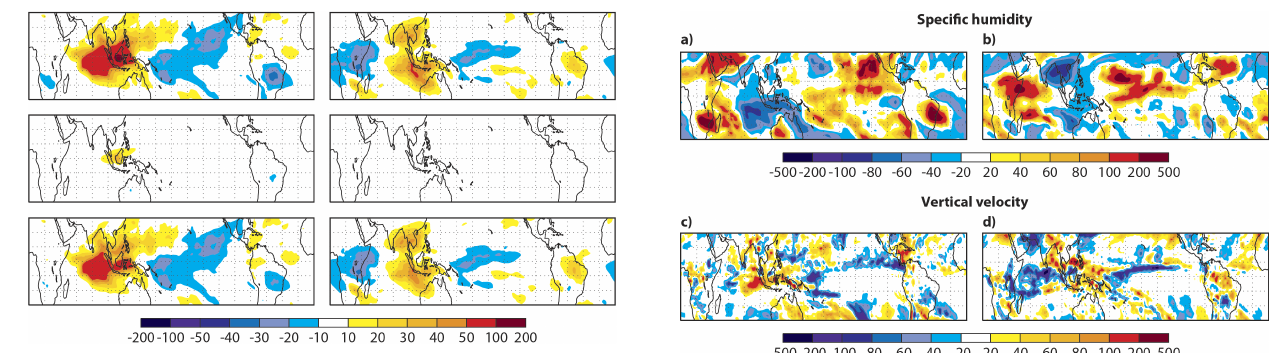
Figure 16. Top panels: specific humidity differences at 500hPa in percent for October (a) and December (b) from the experiments BASE06 minus BASE05. Blue colours show reduced specific hu- midity, red colours increased values. Bottom panels: differences of vertical velocity in mms − 1 for October (c) and December (d) from the experiments BASE06 minus BASE05. Blue colours show in- creased ascent, red colours increased descent.